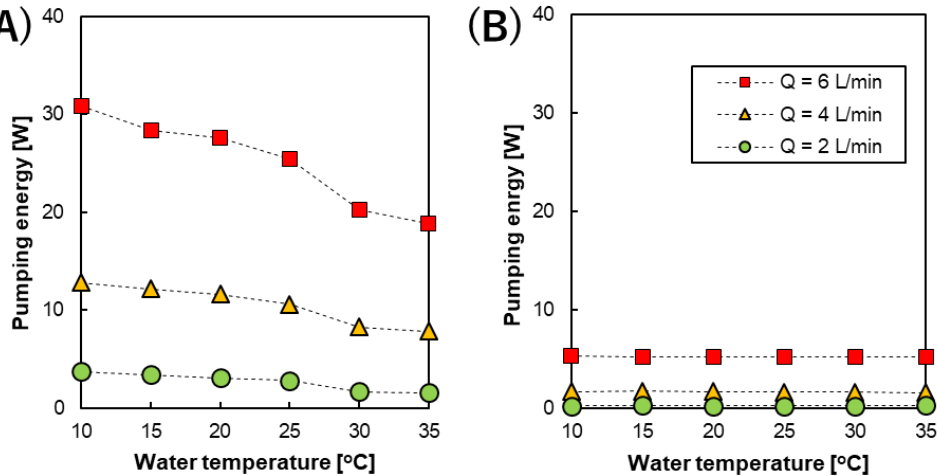
Figure 6. The temperature dependence of the pumping energy calculated from the pressure drop of the stack with an intermediate distance of ( A ) 200 and ( B ) 600 µm at different feed solution flow rates.